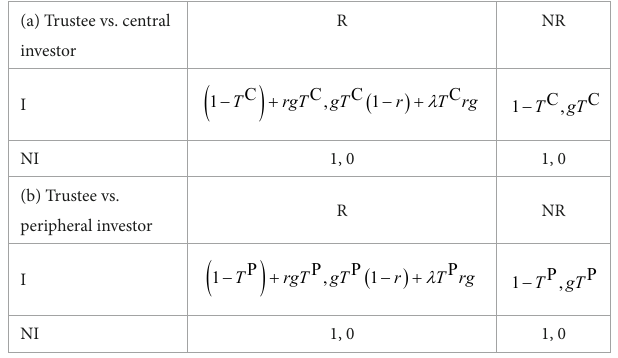
TABLE 9 Utility matrix between trustee and